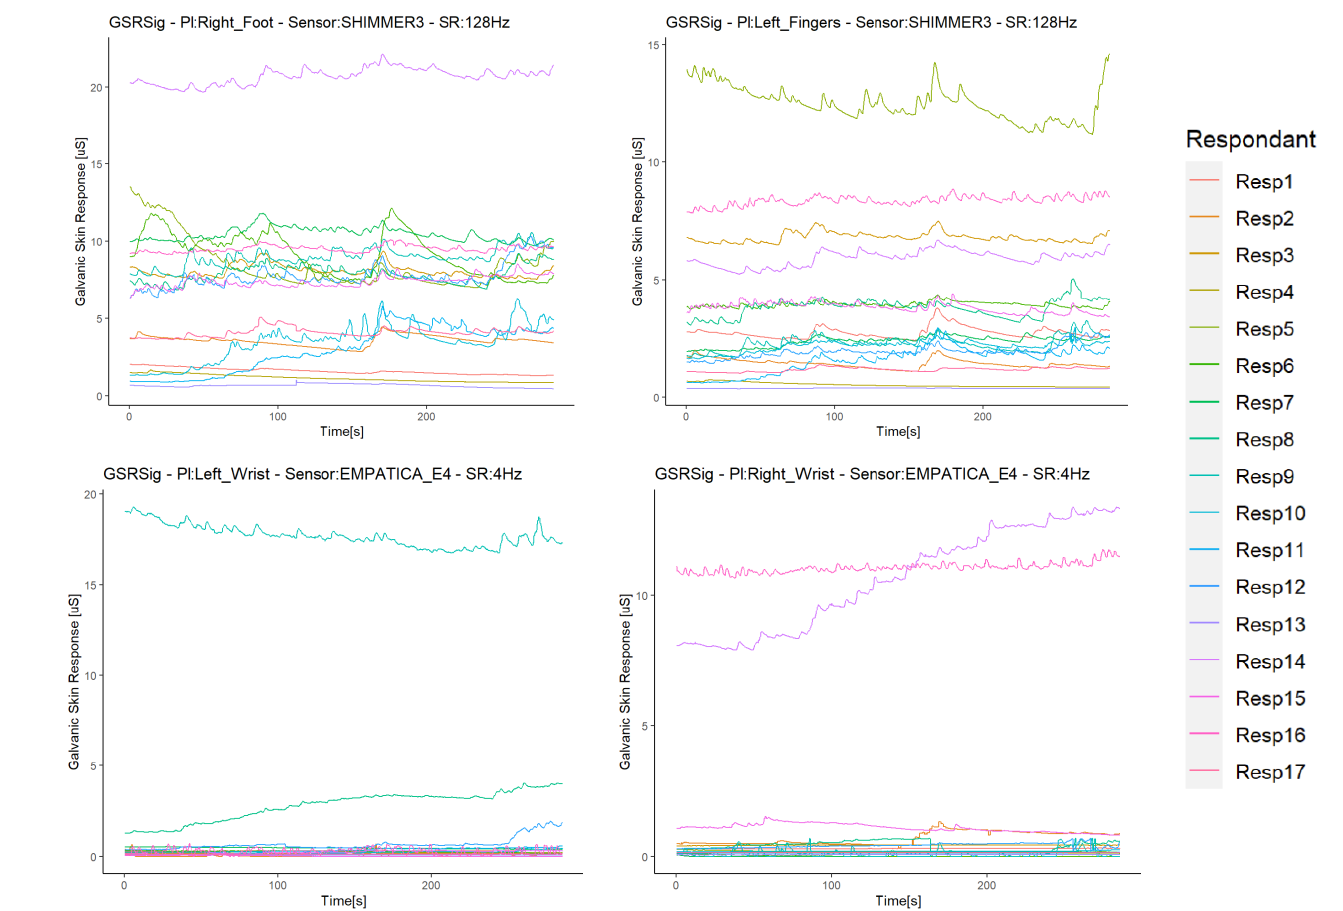
Figure 3. Time series of each signal dataset for the respondents.